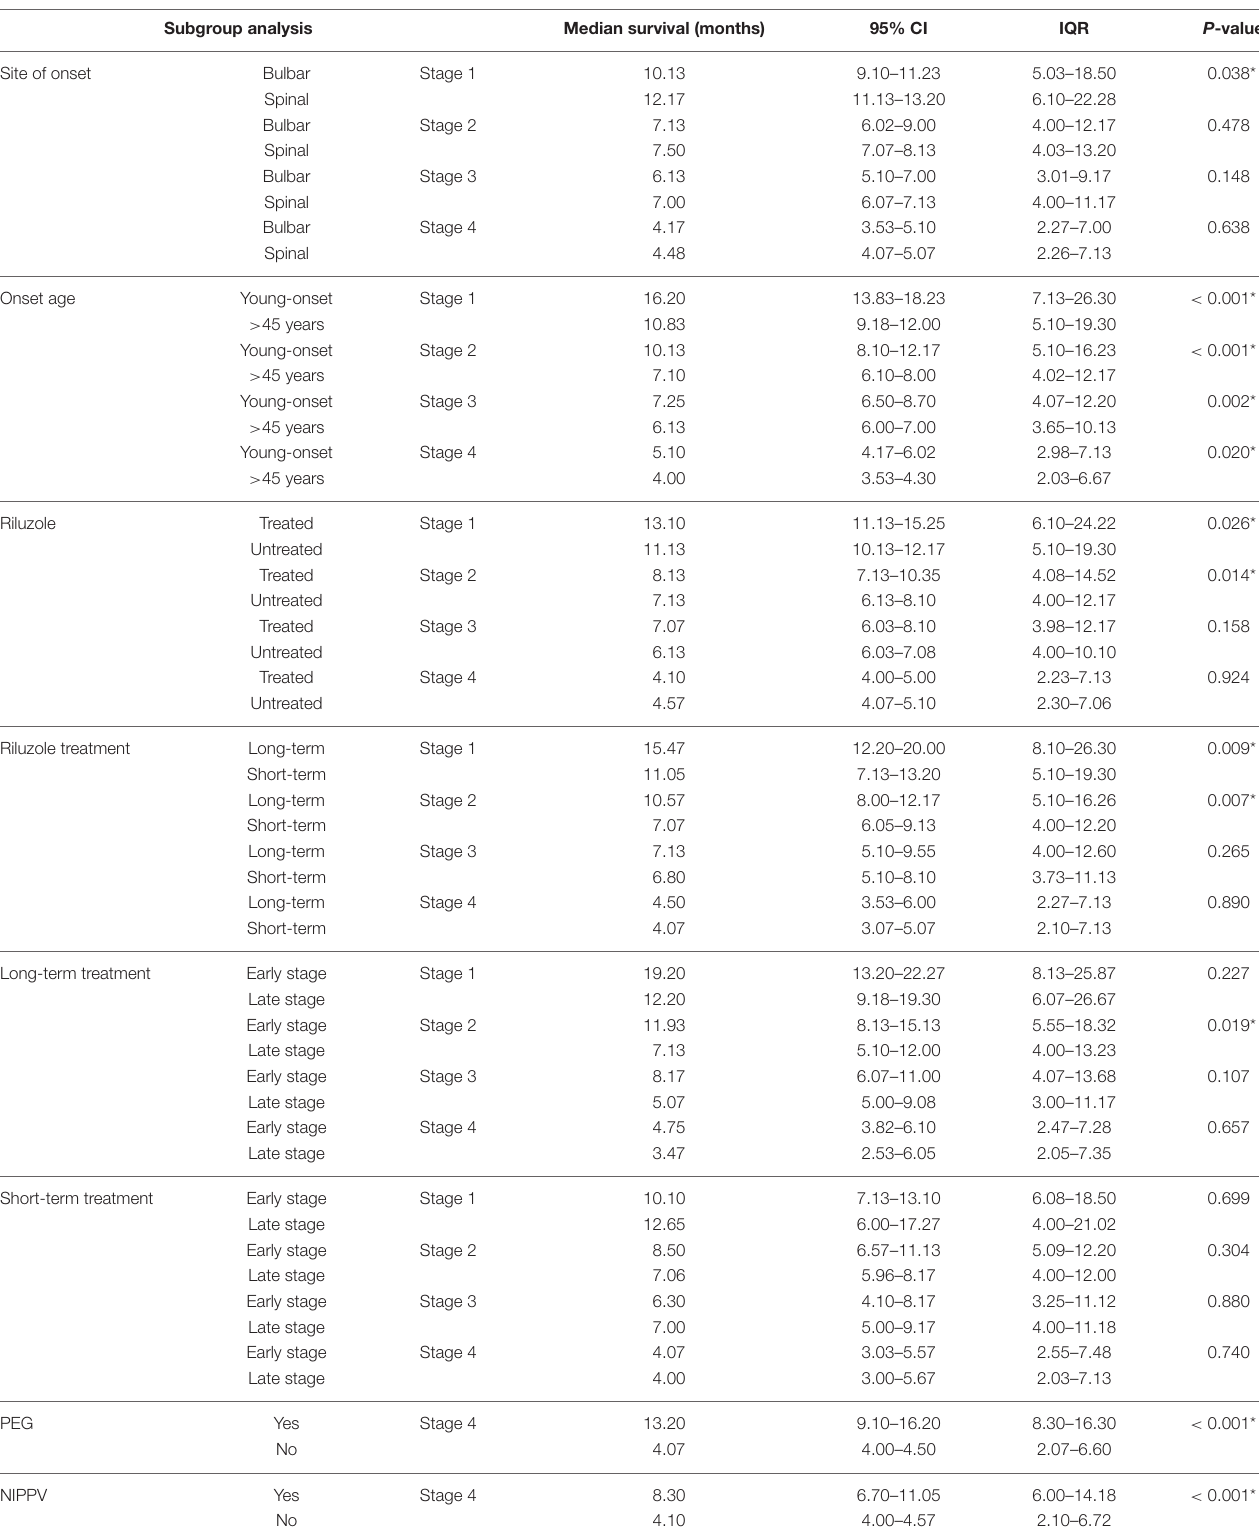
TABLE 2 | Subgroups analysis in ALS patients. Subgroup